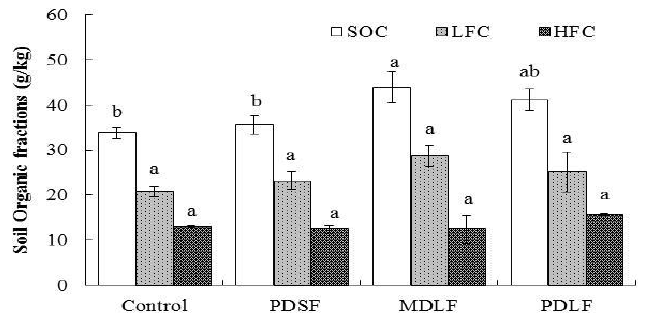
Figure 1. Effect of Plant-derived solid (PDSF), mineral-derived liquid (MDLF), and plant-derived liquid (PDLF) fulvic acids (FA) on soil organic carbon, light fraction C, and heavy fraction C. Error bars represent standard errors of the means ( n = 4). The least significant differences (LSD 0.05 ) are at 5% level of significance. Different letter on top of each bar showing significant differences between treatments.